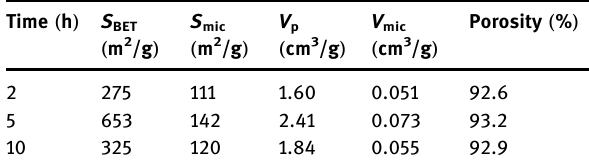
Table 2: Pore structure data of C/SiO 2 aerogel with di ff erent thermal treatment time at